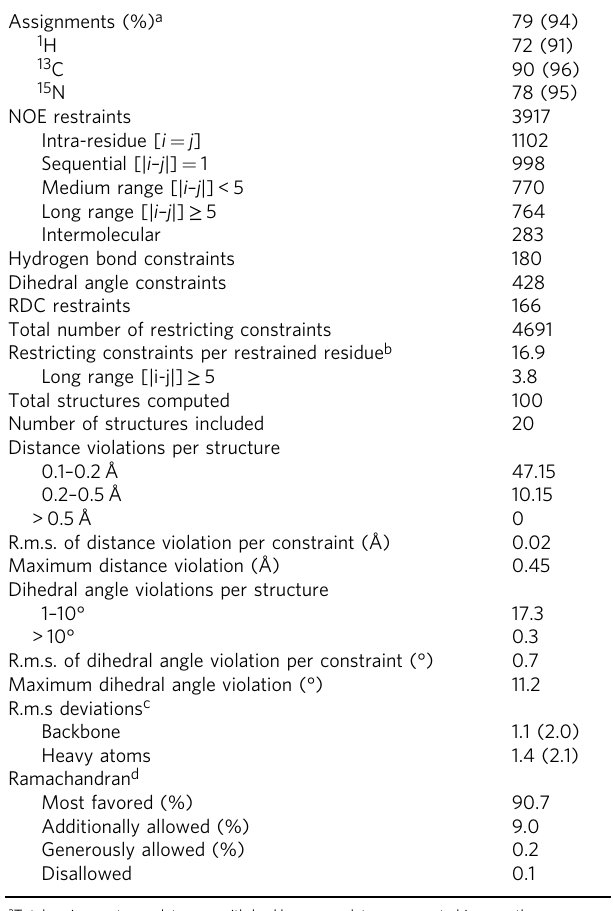
Table 1 Structural statistics for the CARD9 2 − 142 dimer Assignments (%)